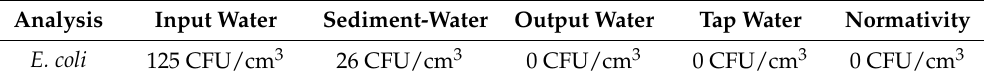
Table 3. Microbiological analysis using the membrane filtration method.